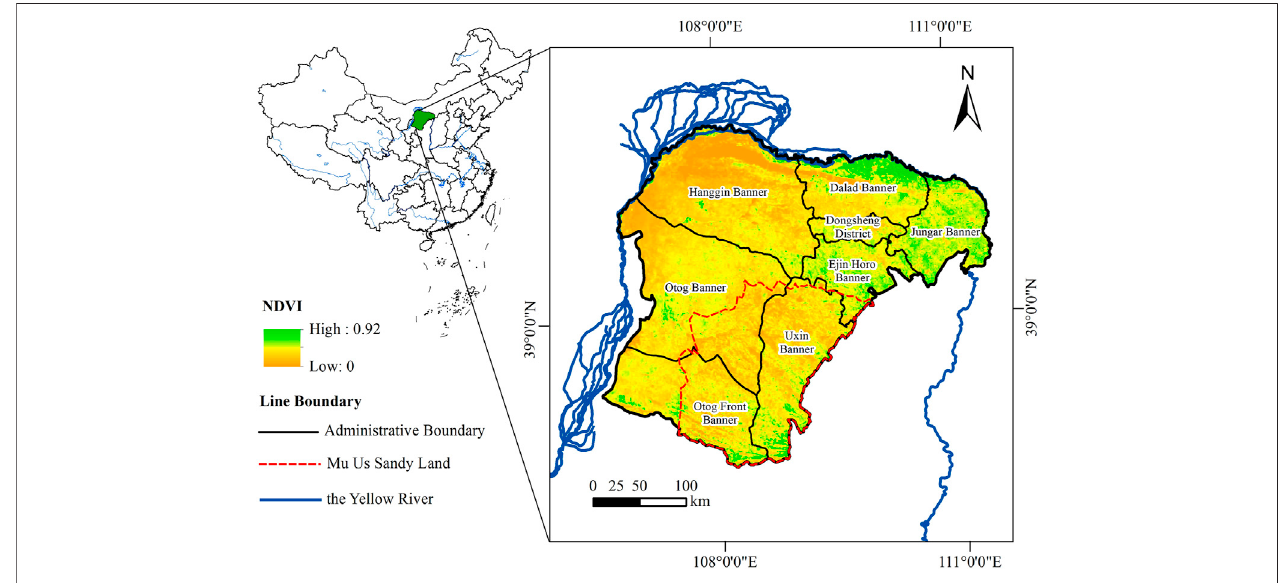
FIGURE 1 | Location of the study